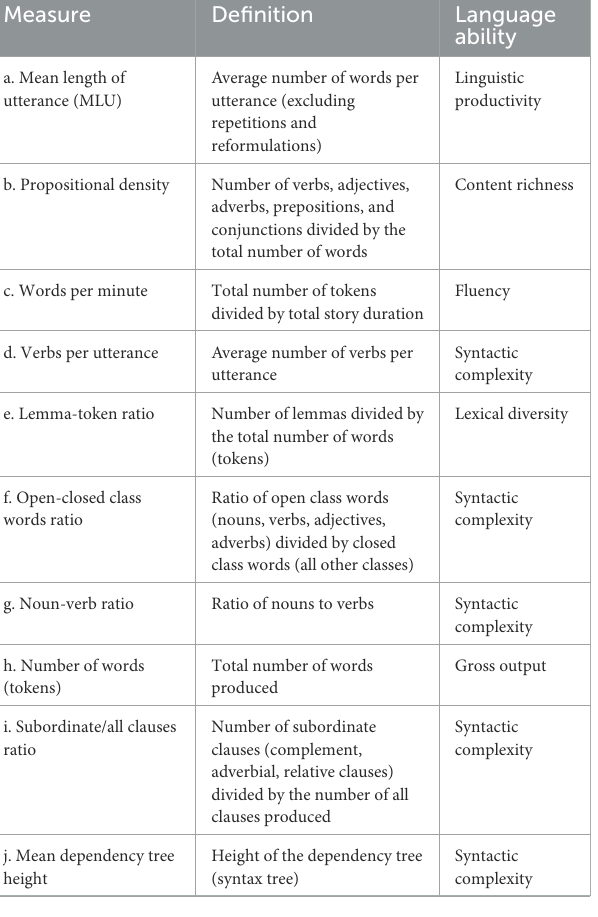
TABLE 4 Linguistic measures for analyzing discourse production and their correspondence to language abilities ( a.-h. adapted from Stark, 2019).